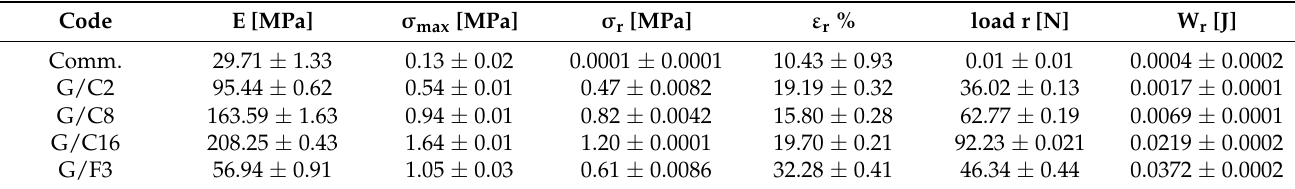
Table 3. Mechanical characteristics of the coating.